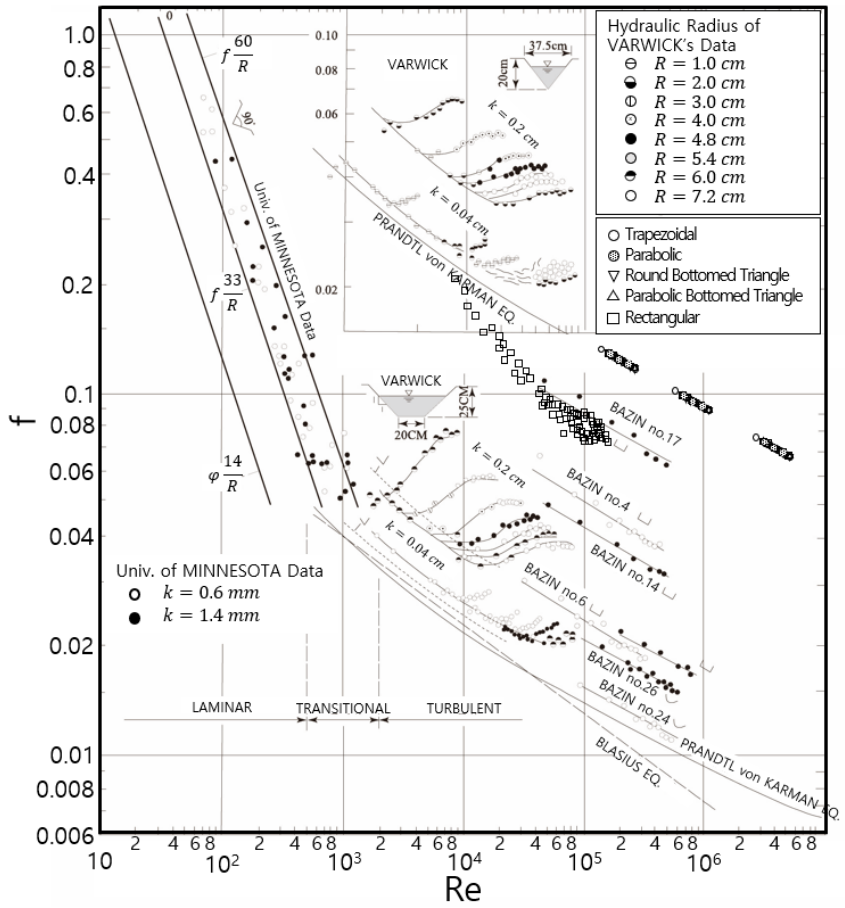
Figure 13. The comparison between the empirical and calculated friction coefficients using Yuen